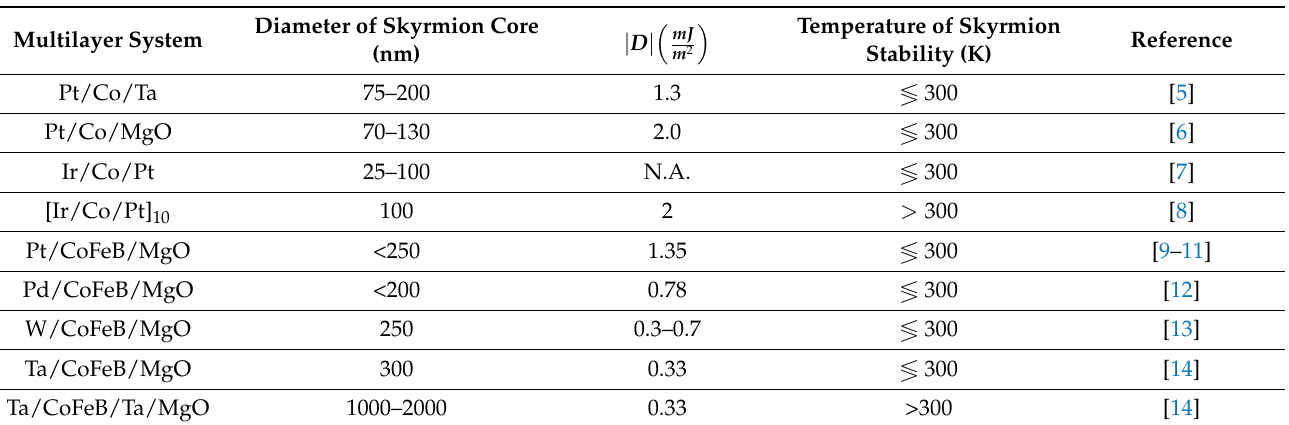
Table 1. Selection of thin film multilayered materials illustrating N é el skyrmion stabilization. We indicate the material (multilayer system), the measured diameter of the skyrmion core, the magnitude (cid:16) (cid:17) mJ of the DMI | D | , the temperature of the skyrmion stability and the reference of the paper m 2 containing the